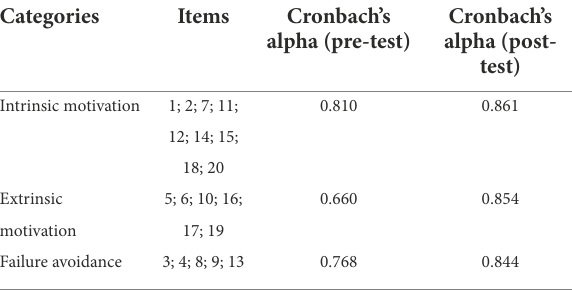
TABLE 1 Overview of the research motivation scale.